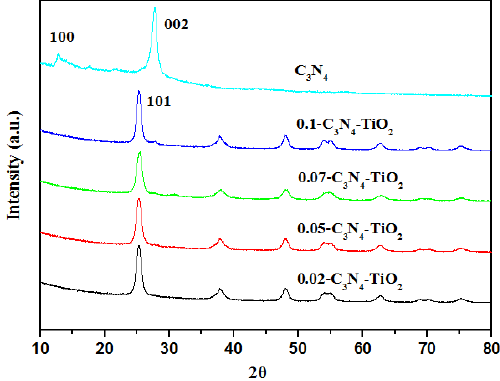
Figure 2. X ‐ ray diffraction (XRD) pattern of g ‐ C 3 N 4 ‐ TiO 2 . Figure 2. X-ray diffraction (XRD) pattern of g-C